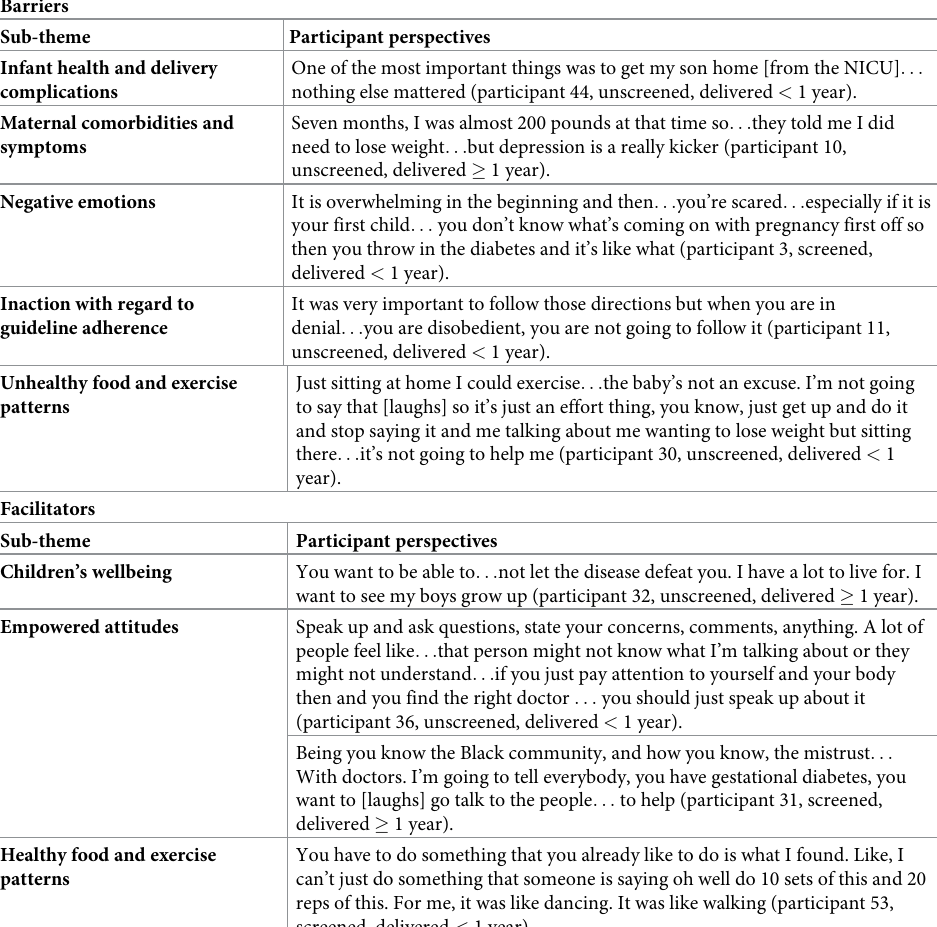
Table 5. Individual (patient) level barriers and facilitators to postpartum diabetes screening and prevention: Exemplar